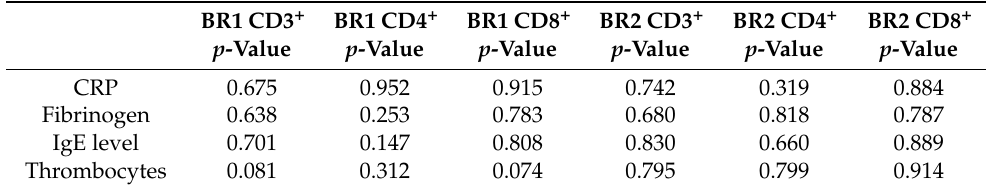
Table 4. Correlation between tested blood parameters: CRP, fibrinogen, IgE concentration, thrombocyte levels, and bradykinin receptor expression in CSU patients. Statistical significance of the results was analyzed with a Spearman test.